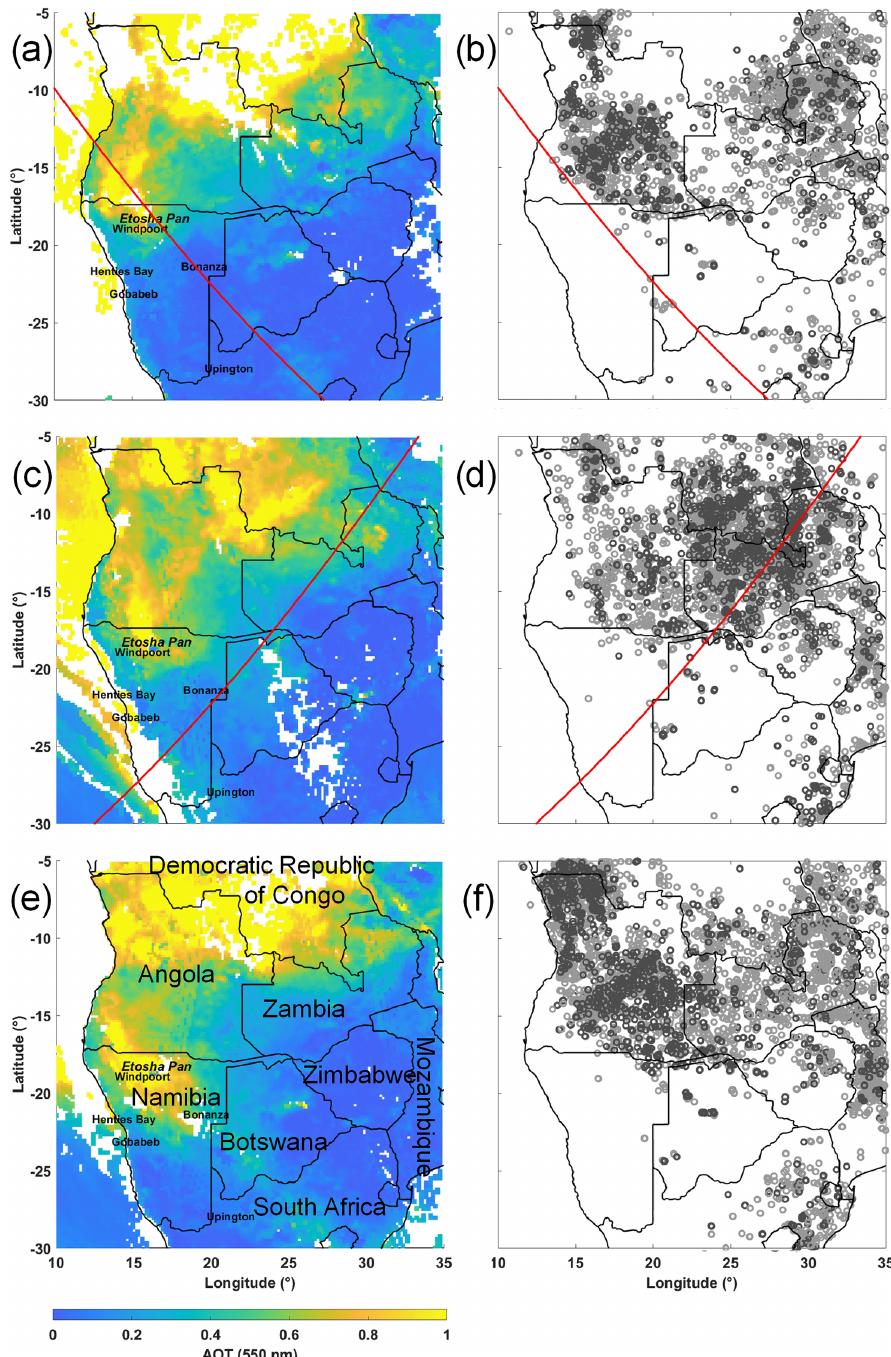
Figure 6. AOT (a, c, e) on and fire hotspot location (b, d, f) derived from MODIS on 4 (a, b) , 5 (c, d) and 6 (e, f) September 2017. The CATS tracks overpassing Namibia on 4 and 5 September are overlain in panels (a, b) and (c, d) as a solid red line. The confidence in the detection of the location of the fire hotspots is indicated by the color of the circles (dark circles indicating high confidence and grey circles nominal confidence, as provided by the MODIS